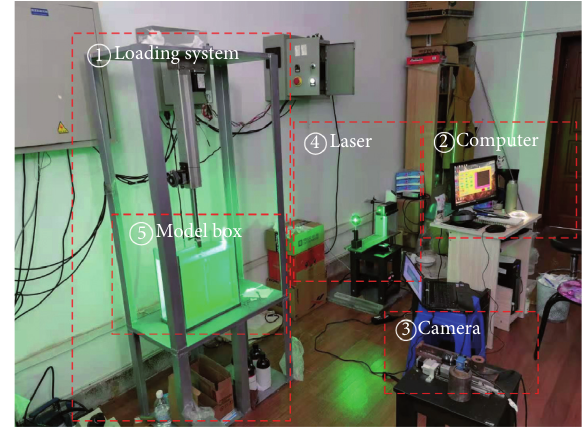
Figure 1: Experimental system.